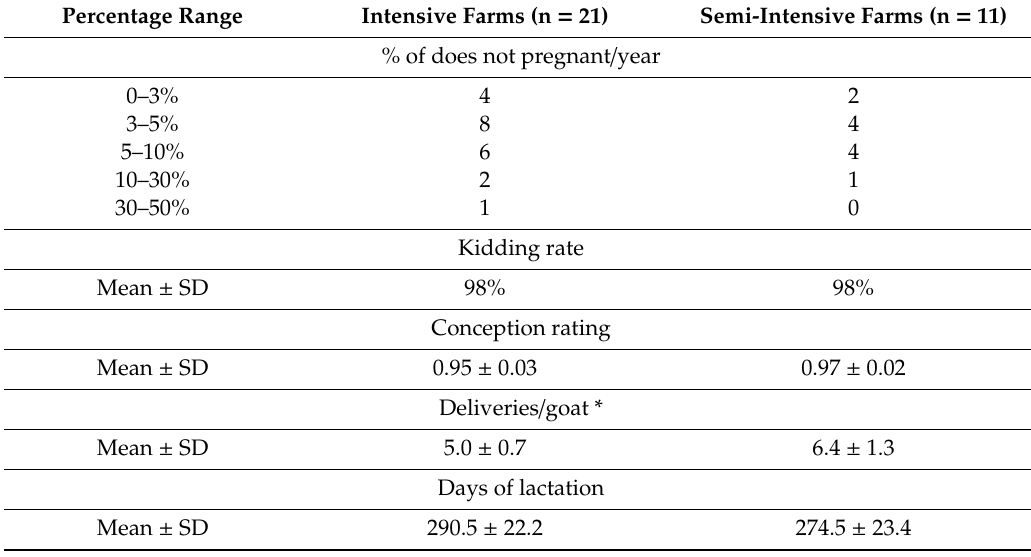
Table 4. Reproductive parameters registered in intensive and semi-intensive goat farms, Northwestern Italy. Percentage Range Intensive Farms (n = 21) Semi-Intensive Farms (n =